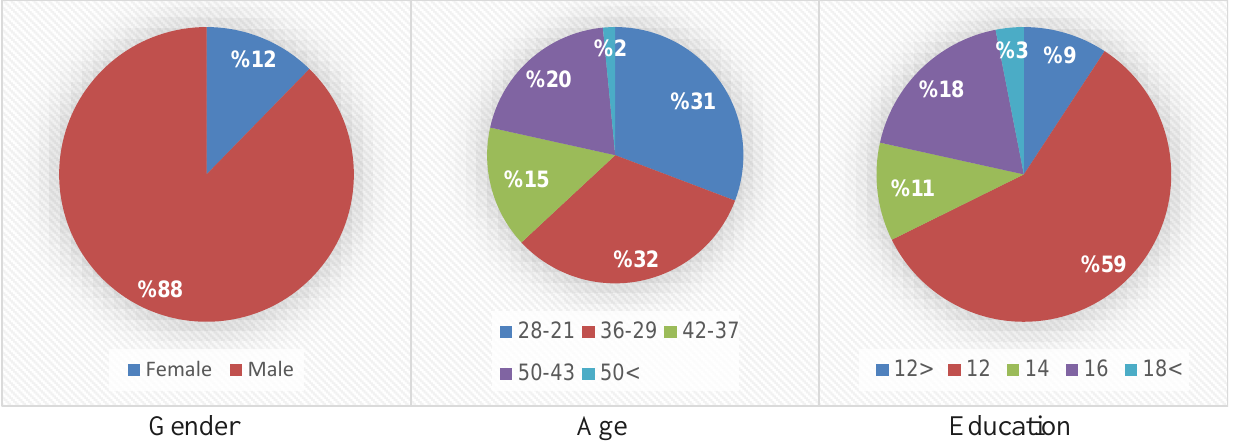
Fig. 1. Personal characteristics of the participants